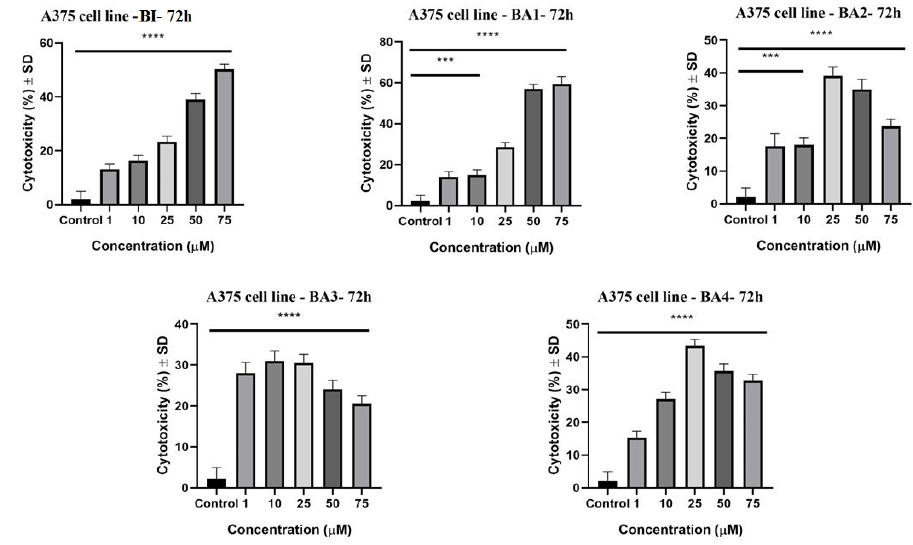
Figure 3. The cytotoxic activity of BI, BA1, BA2, BA3, and BA4 at concentrations of 1, 10, 25, 50, and 75 µ M on A375 cells after 72 h of incubation. The data are presented as a cytotoxicity percentage (%) ± SD compared to control cells. A one-way ANOVA test and Dunnett’s multiple comparison post-test were used to compare the groups (*** p ≤ 0.001; **** p ≤ 0.0001 vs. control).